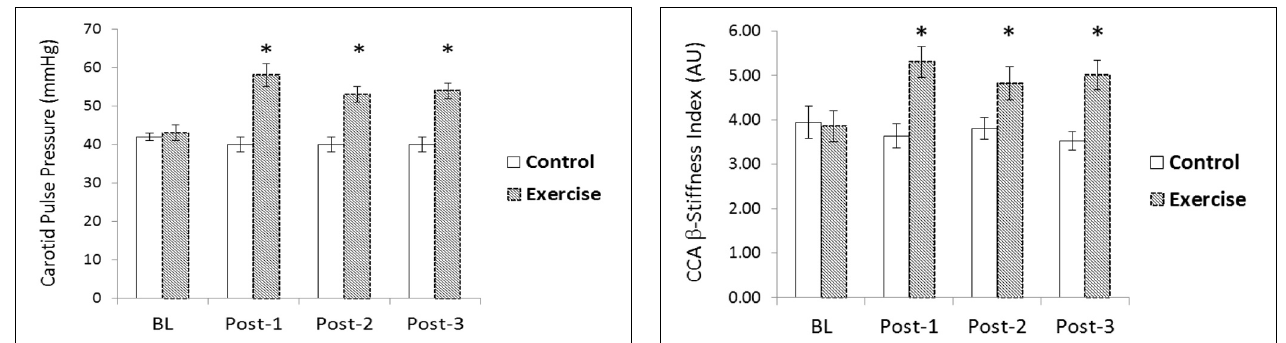
FIGURE 1 | Change in carotid pulse pressure (PP) following acute resistance exercise (RE) vs. a time control condition. A significant condition-by-time interaction was detected for carotid PP ( p < 0 . 05). Carotid PP was elevated 10, 20, and 30-min after exercise compared to baseline ( p < 0 . 05) ∗ .